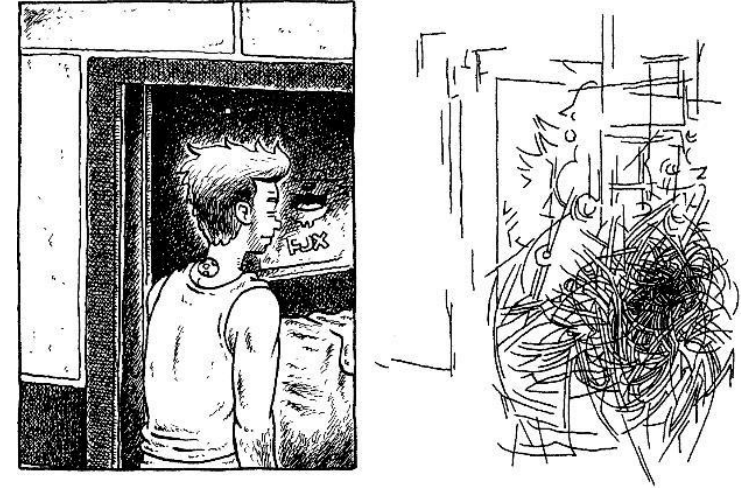
Figure 10. From Cotter, Nod Away , 183. Copyright, 2016, Joshua W